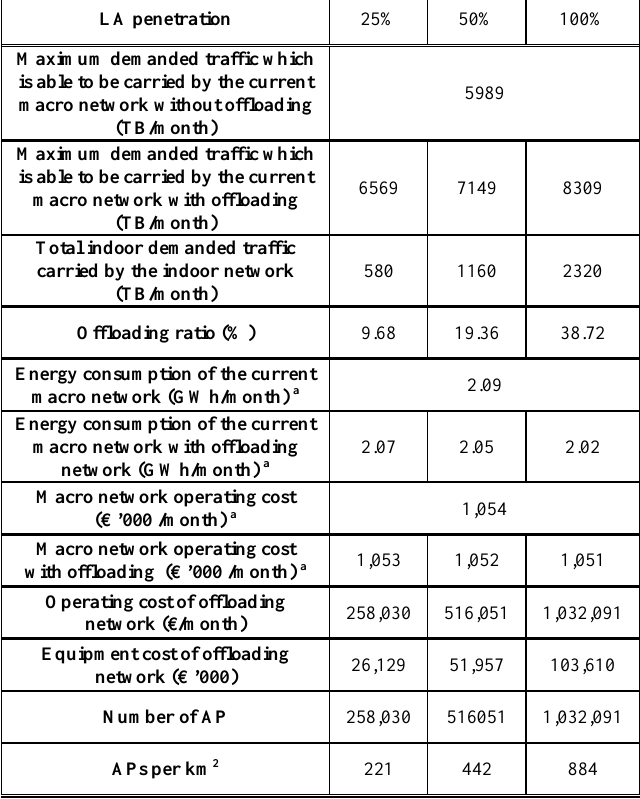
Table 1. Wide-to-local area offloading